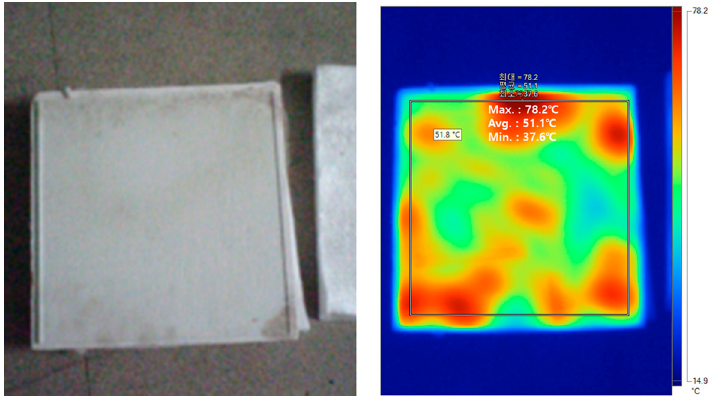
Figure 8. Experimental for a glass-heating temperature of 100 °C and a heating rate of 8 °C/min. An image of the glass ( left ) and the corresponding temperature distribution ( right ).